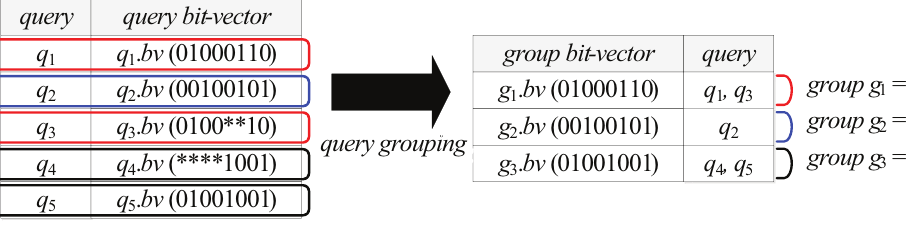
Figure 4. An example of query